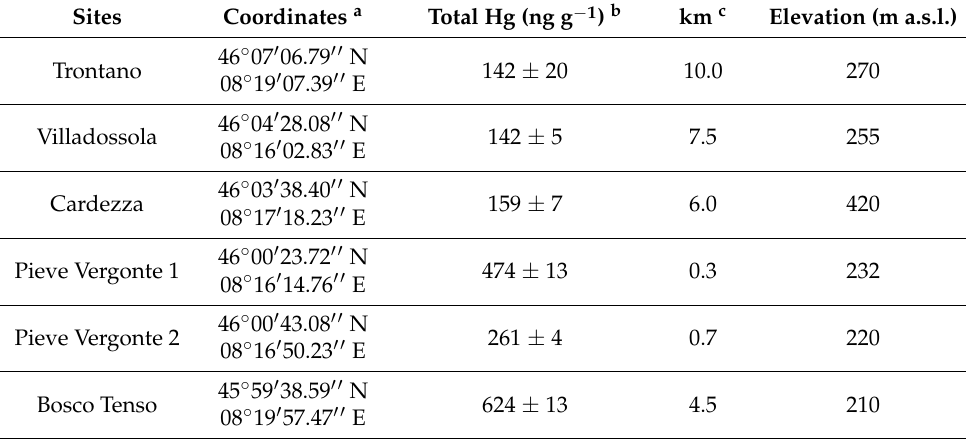
Table 1. Total Hg concentration in lichens samples. a Sites coordinates of lichens; b Mean ± sd (ng g − 1 , dry weight); c Distance from the center of the chlor-alkali plant (0.3 km